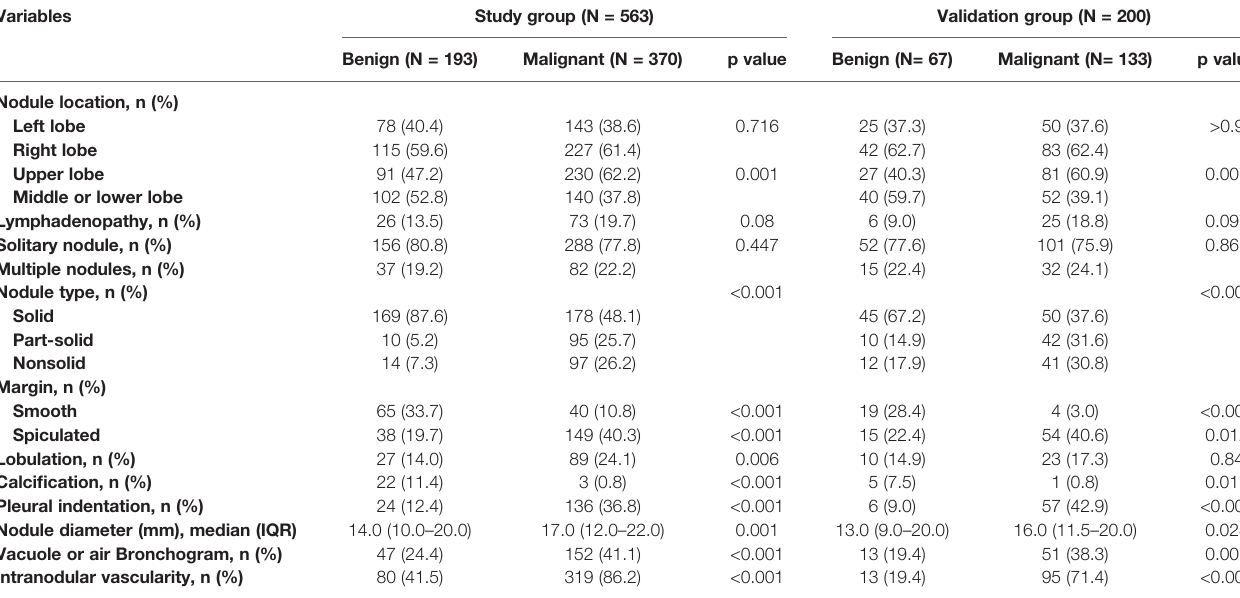
TABLE 2 | CT characteristics of the nodules according to lung cancer status in the study and validation datasets. Variables Study group (N = 563)